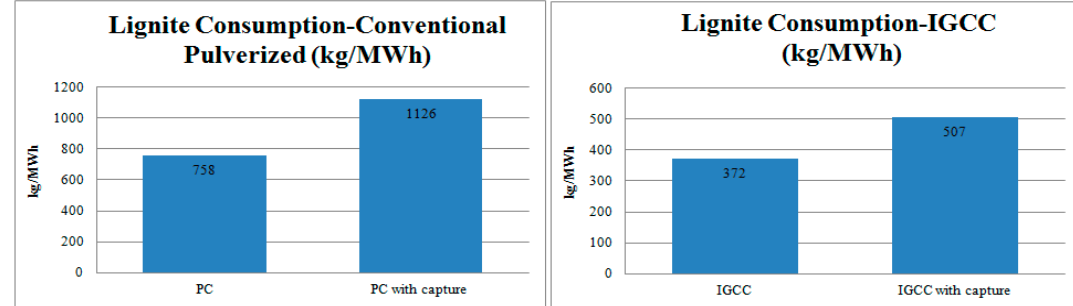
Figure 6. Net power output for four scenarios.